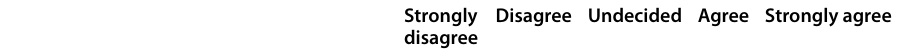
Learning materials and